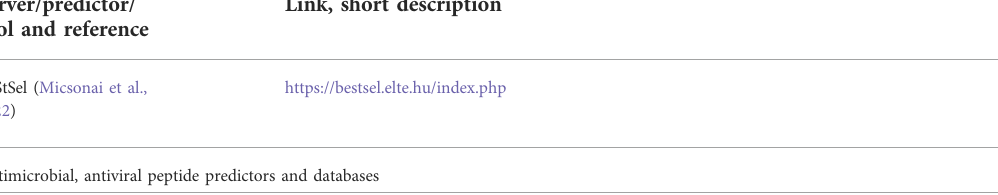
TABLE 1 ( Continued ) Online databases and tools to predict and characterize CPPs, bioactive CPPs and